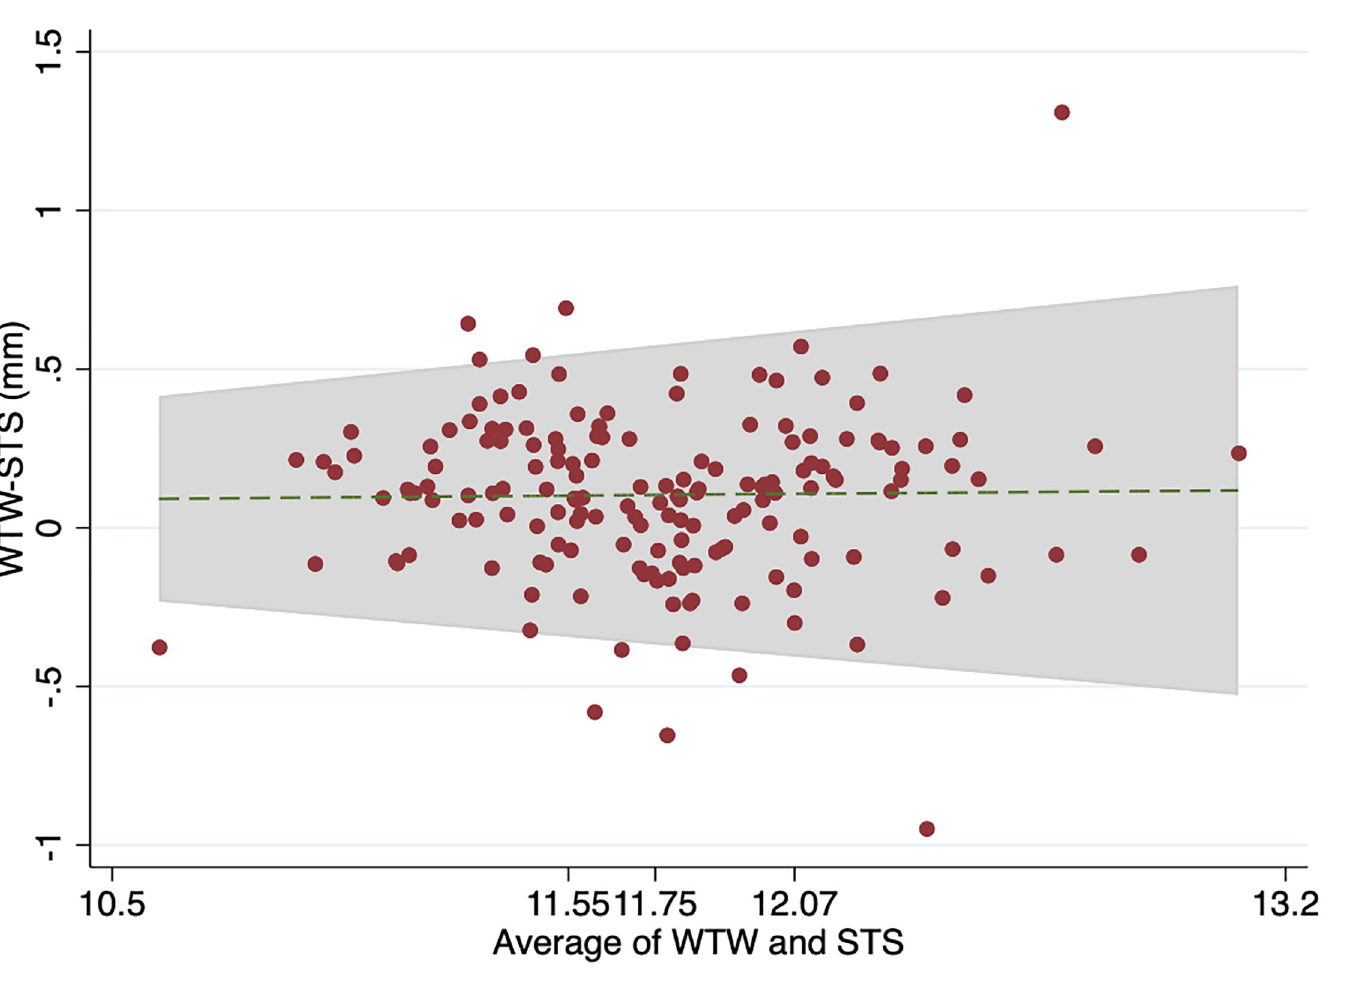
Fig 4. Bland-Altman plots with trend for WTW-STS and average of WTW and STS. WTW value of equal to or less than 11.55 mm is a first quartile, value of 11.55 to 11.75 mm represents the second quartile, value of 11.76 to 12.07 mm represents the third quartile, and value of greater than 12.07 mm is a fourth quartile. WTW white-to- white distance; STS spur-to-spur